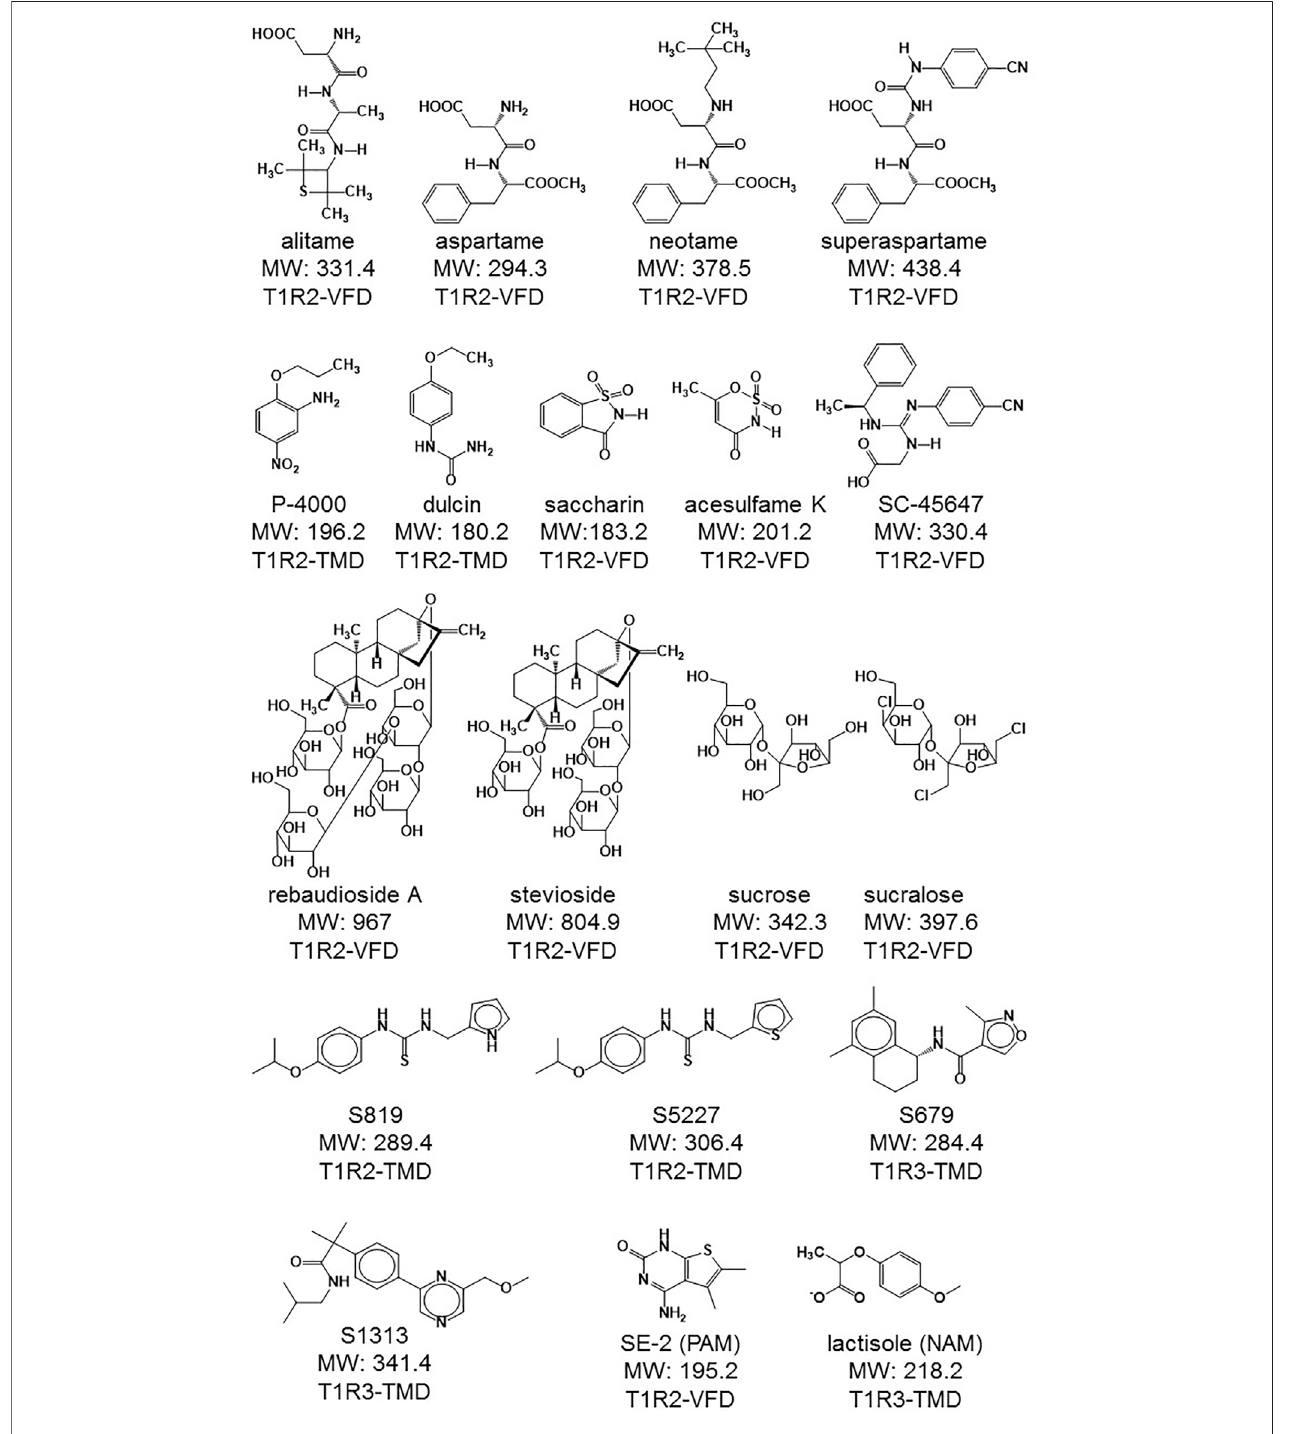
FIGURE1| Structuresofthedifferentagonistsandothermodulatorsusedinthisstudy.Therespectivemolecularweight(MWing/mol)isalsoindicatedaswellastheinteraction site in the human sweet taste receptor subunits. VFD: Venus fl ytrap, TMD: transmembrane domain. Interaction site data retrieved from (DuBois, 2016; Servant et al., 2020).